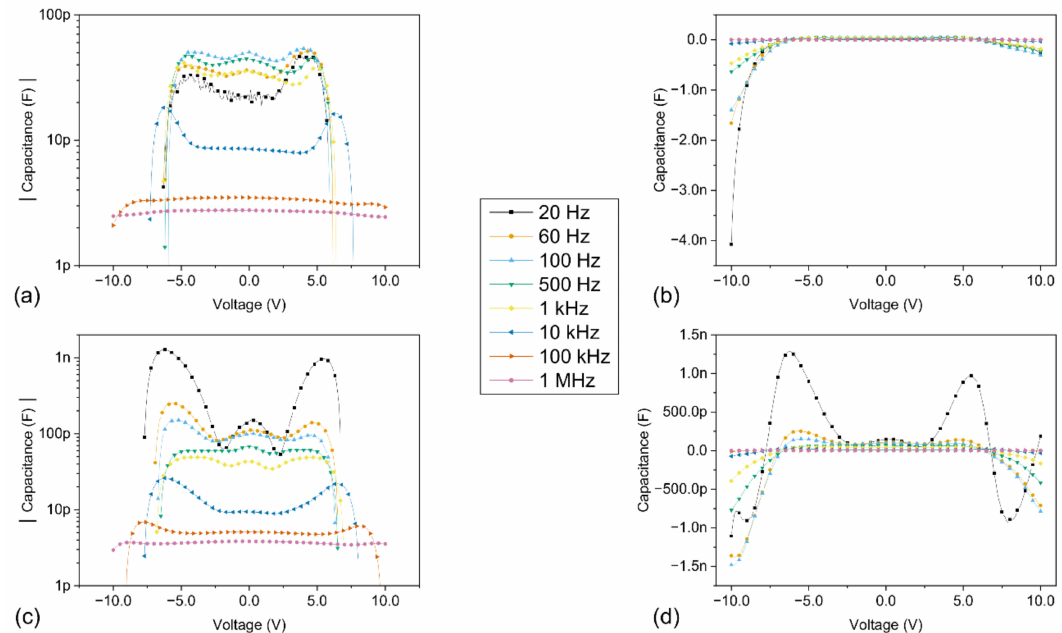
Figure 10. (C-V) characteristics under dark and light conditions, for different fixed frequencies of the AC modulation superimposed to the DC bias and ranging between 20 Hz and 1 MHz. The voltage was swept between − 10 V and 10 V, with a step voltage of 100 mV; ( a ) log scale under dark conditions; ( b ) linear scale under dark conditions; ( c ) log scale under light conditions; ( d ) linear scale under light conditions. Only the positive capacitance values are displayed in the graphs ( a , c ) with a log scale.